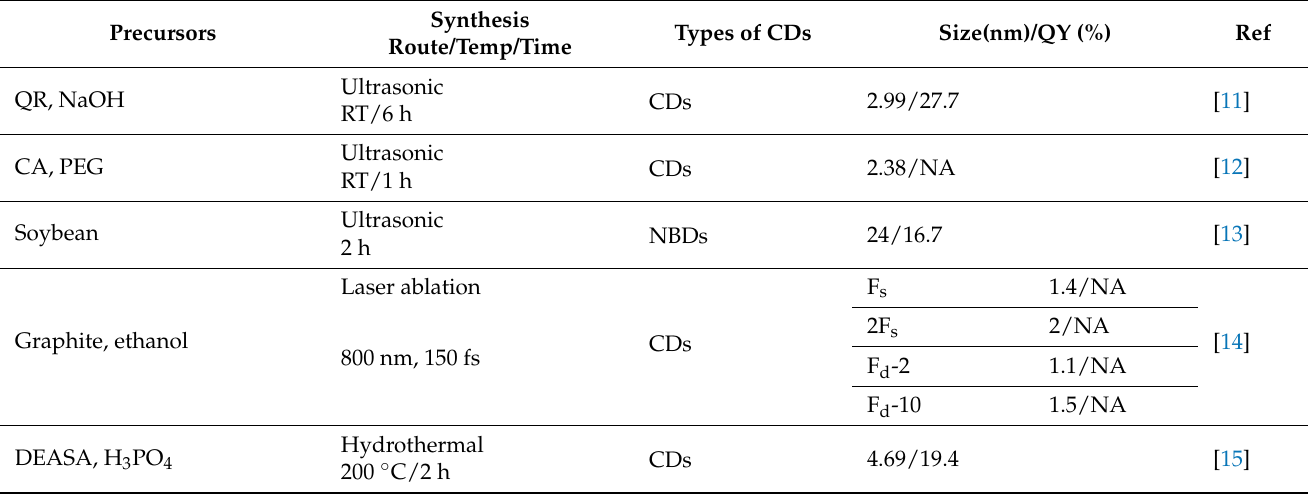
Table 1. Synthesis of carbon dots (CDs) following top-down and bottom-up